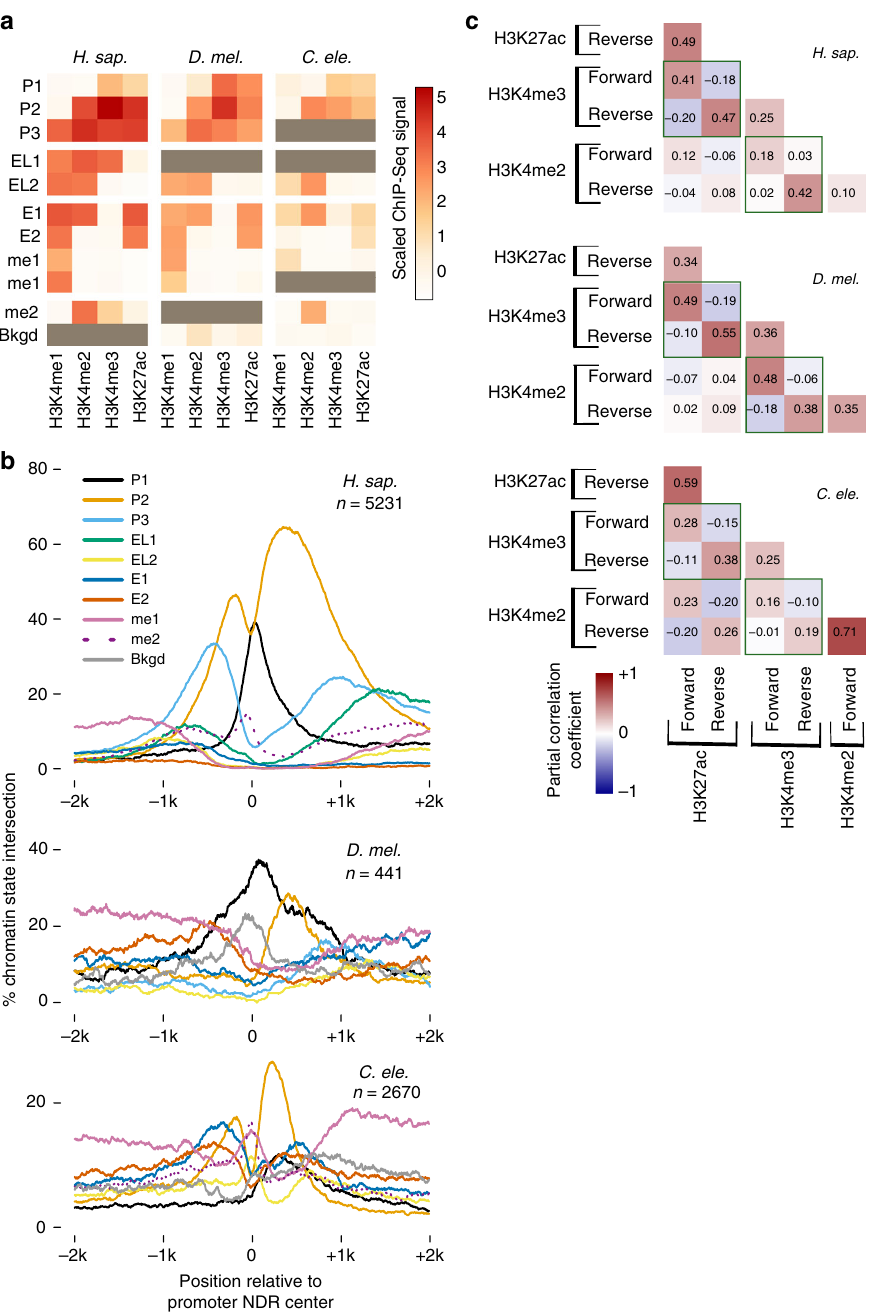
chromatin states (Fig. 3a) at enhancer NDRs. As expected, we found enhancers are on average depleted of promoter-associated states (Fig. 5a) and of H3K4me3 (Supplementary Fig. 6a), but with noticeable variation across species. H. sapiens and C. elegans enhancers feature weak H3K4me3 enrichment seen in chromatin states P3 and P2 respectively (Fig. 5a), while D. melanogaster enhancers have relatively low coverage of E1 (H3K27ac,